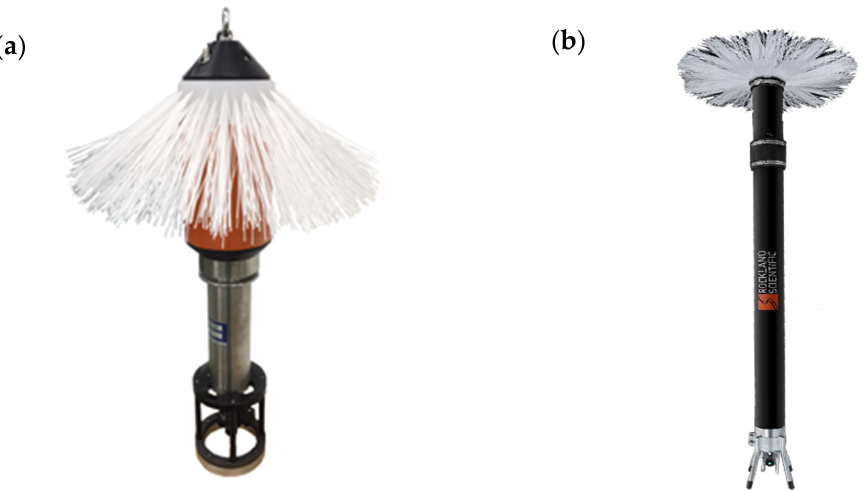
Figure 1. ( a ) The Yoing Ocean Data Acquisition (YODA) profiler. ( b ) The VMP-250 turbulence profiler .